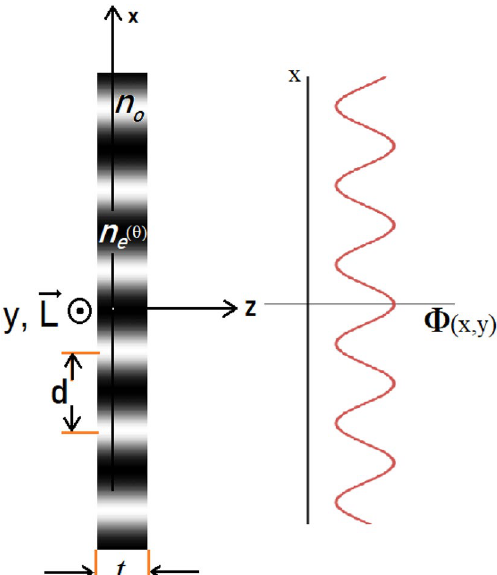
Figure 2. Sinusoidal phase grating inside the LC